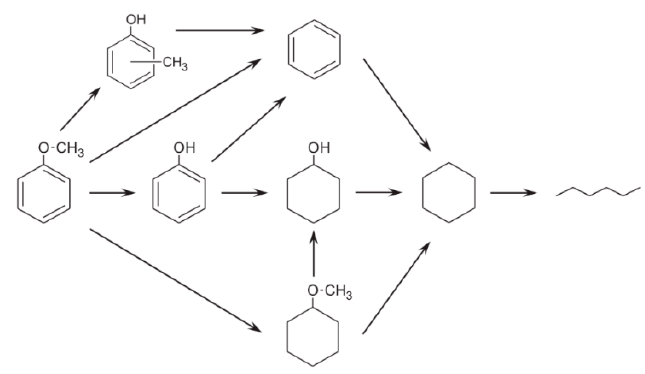
Figure 8. Scheme of the possible routes for anisole HDO from ref [52] .